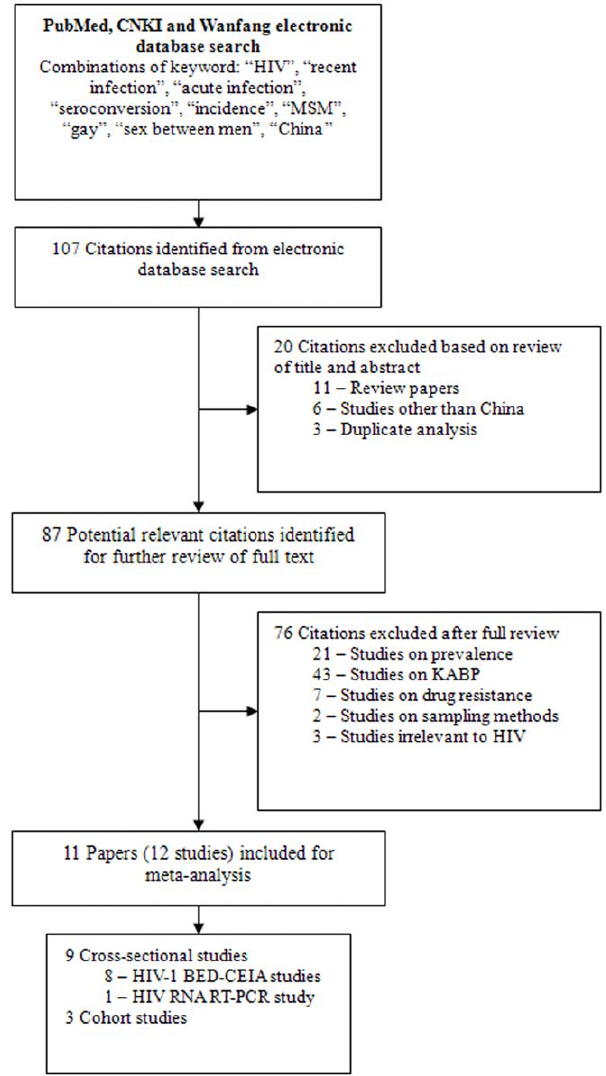
Figure 4. Identification, review, and selection of studies included in the